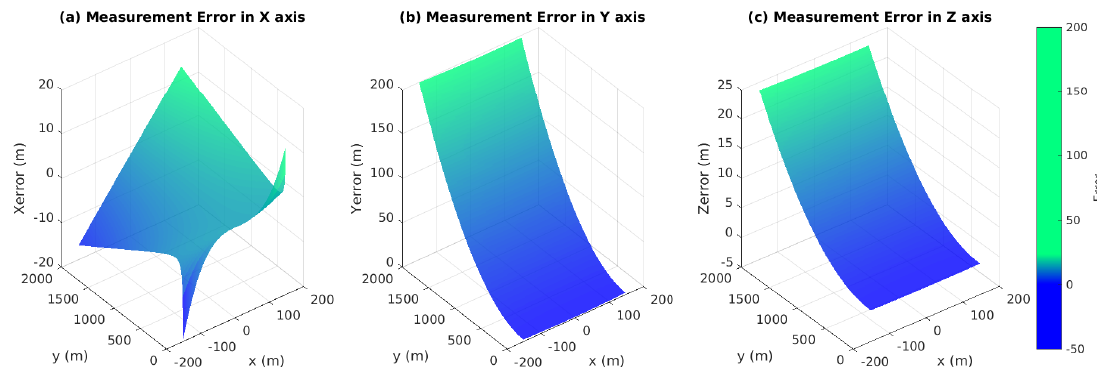
Figure 10. The baseline is 20 m, and the focus is 100 mm. The measurement errors in the X , Z and Y axis with 2000